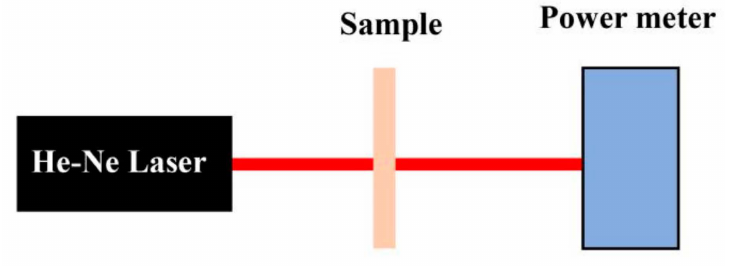
Figure 6. The light path of low power density irradiation.